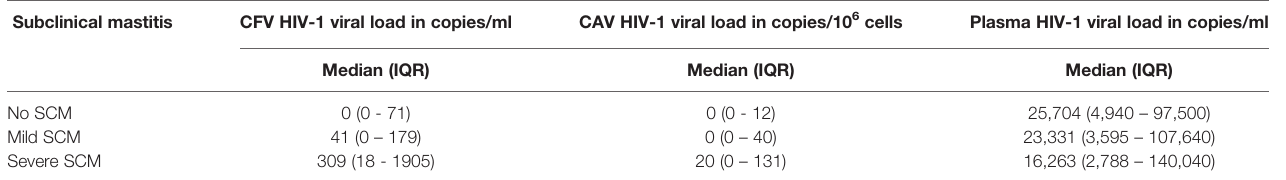
TABLE 3 | Cell free HIV-1 virus (CFV), cell-associated HIV-1 virus (CAV) and Breast Milk Cells (BMC) concentration in breast milk during no, mild and severe subclinical mastitis (SCM).